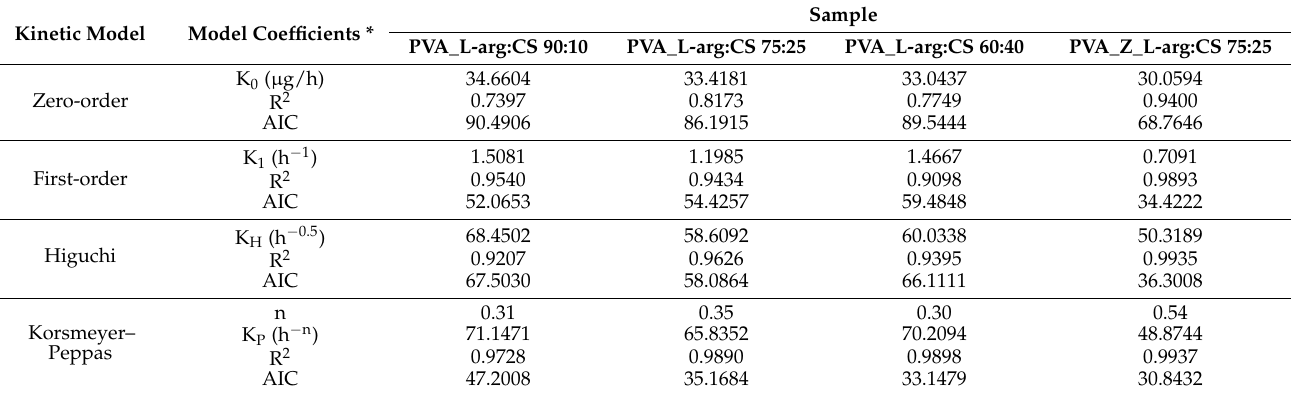
Table 2. Data fitting results of in vitro L-arg release profile from